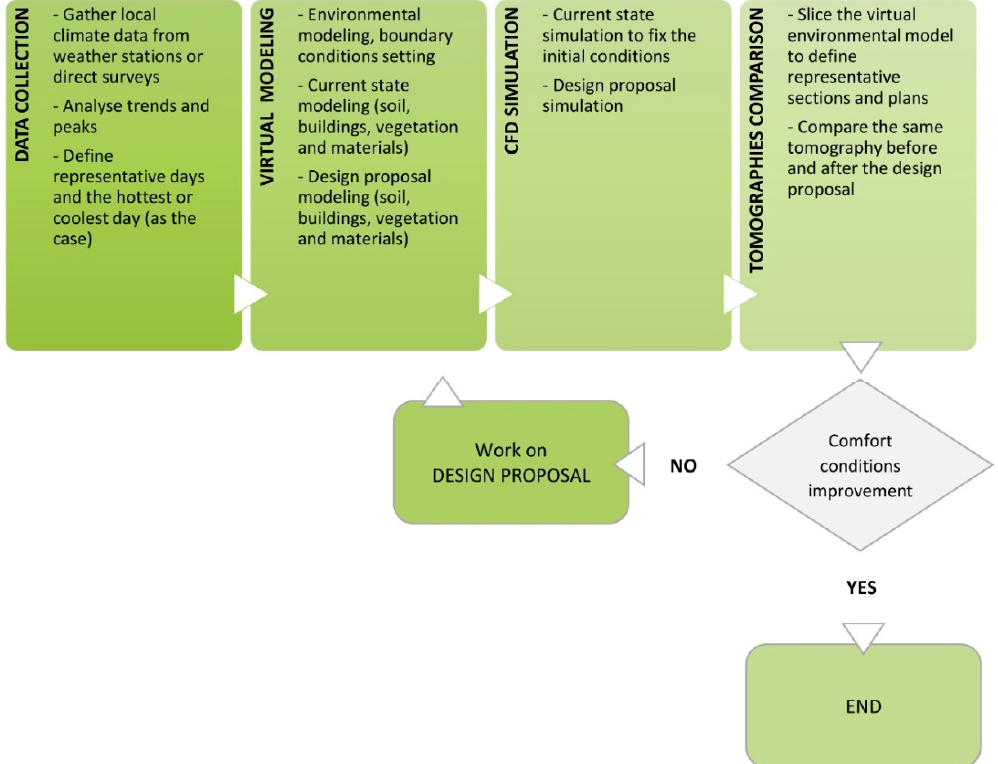
Figure 3. Tomographic environmental section (TENS) workflow.